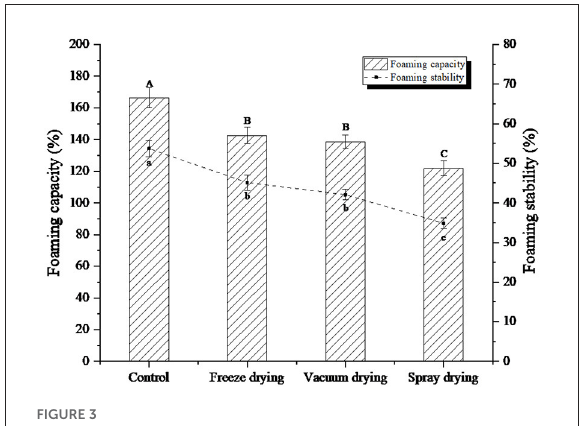
FIGURE3 Foaming capacity and foaming stability of protein peptide powder by three dry methods. Different letters express significant differences ( p < 0.05).